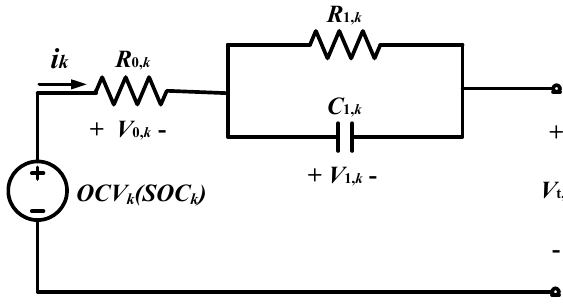
Figure 3. Battery equivalent circuit model.